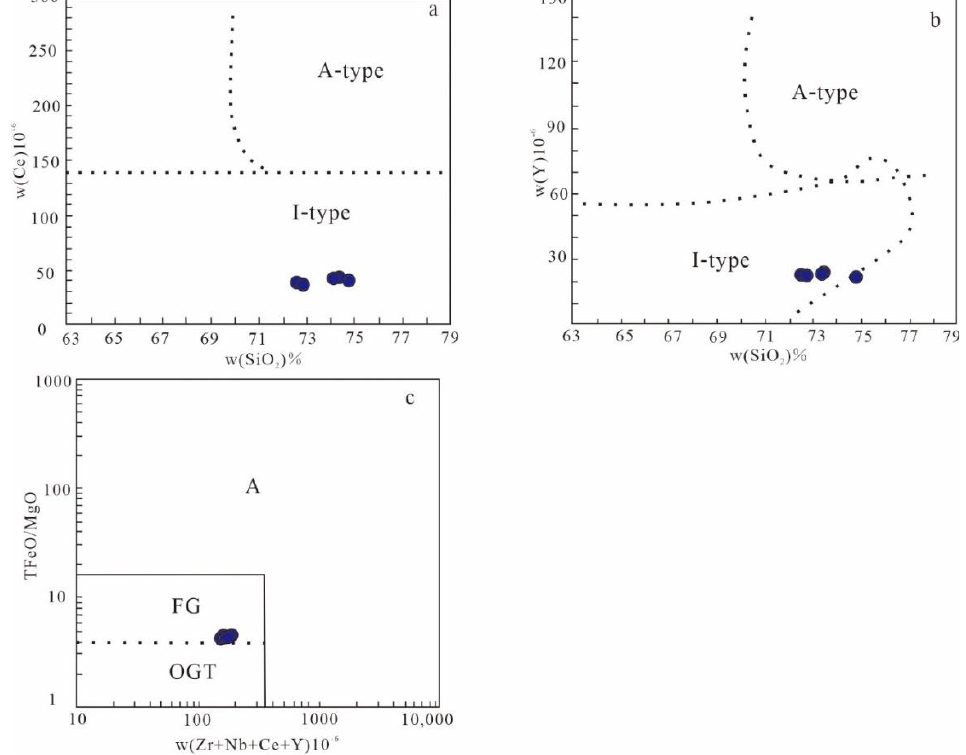
Figure 9. Genetic discrimination map of granitic dykes. ( a ) Ce and SiO 2 granite dykes discriminant diagrams (Collins et al. [56]); ( b ) Y and SiO 2 granites dykes discriminant diagram (Collins et al. [56]); ( c ) T FeO/MgO and Zr + Nb + Ce + Y granites (Whalen, [57]). FG — fractionation acid granites; OGT — unfractionation M, I, and S type granites.